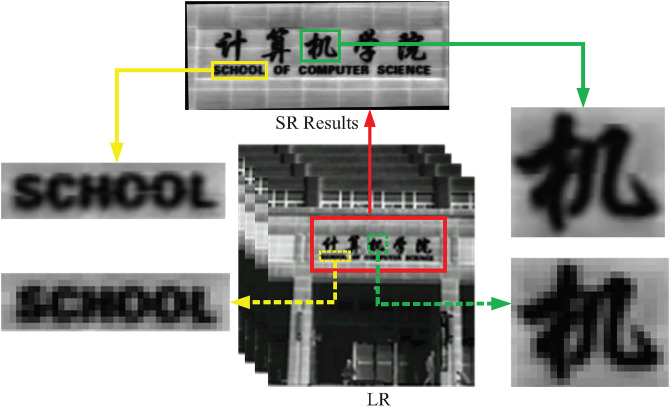
Experimental result of Target 3.